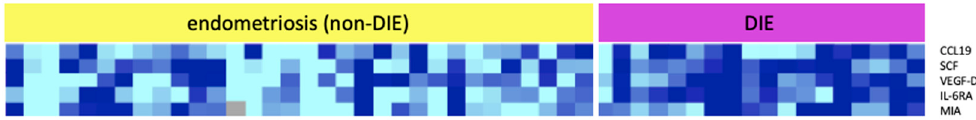
CCL 19, Chemokine ligand 19; SCF, Stem cell factor; VEGF-D, Vascular endothelial growth factor D; IL-6RA, Interleukin-6 receptor alpha; MIA: Melanoma inhibitory activity; DIE: deep-infiltrating endometriosis.